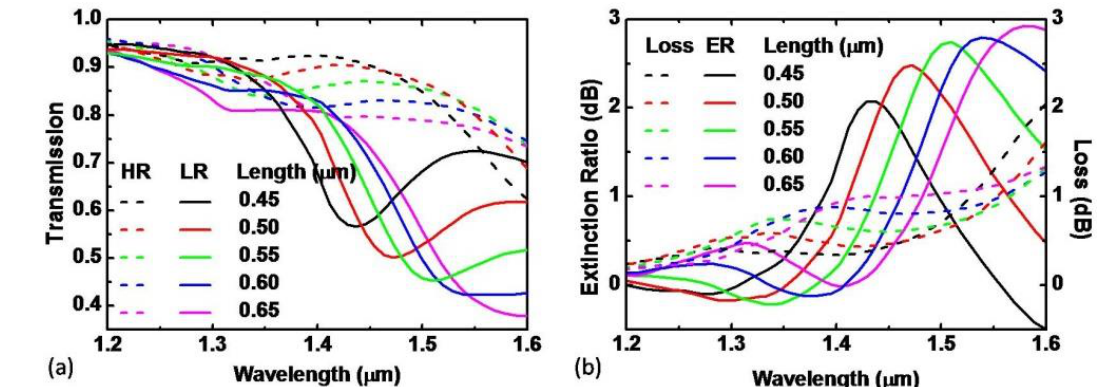
Figure 3. ( a ) Geometry-induced horizontal focusing and ( b ) optimal energy transfer to the taper of the plasmonic memristor at HR state; enhanced plasmon – filament interaction in the plasmonic memristor at LR state due to ( c ) geometry-induced horizontal focusing and ( d ) optimal energy